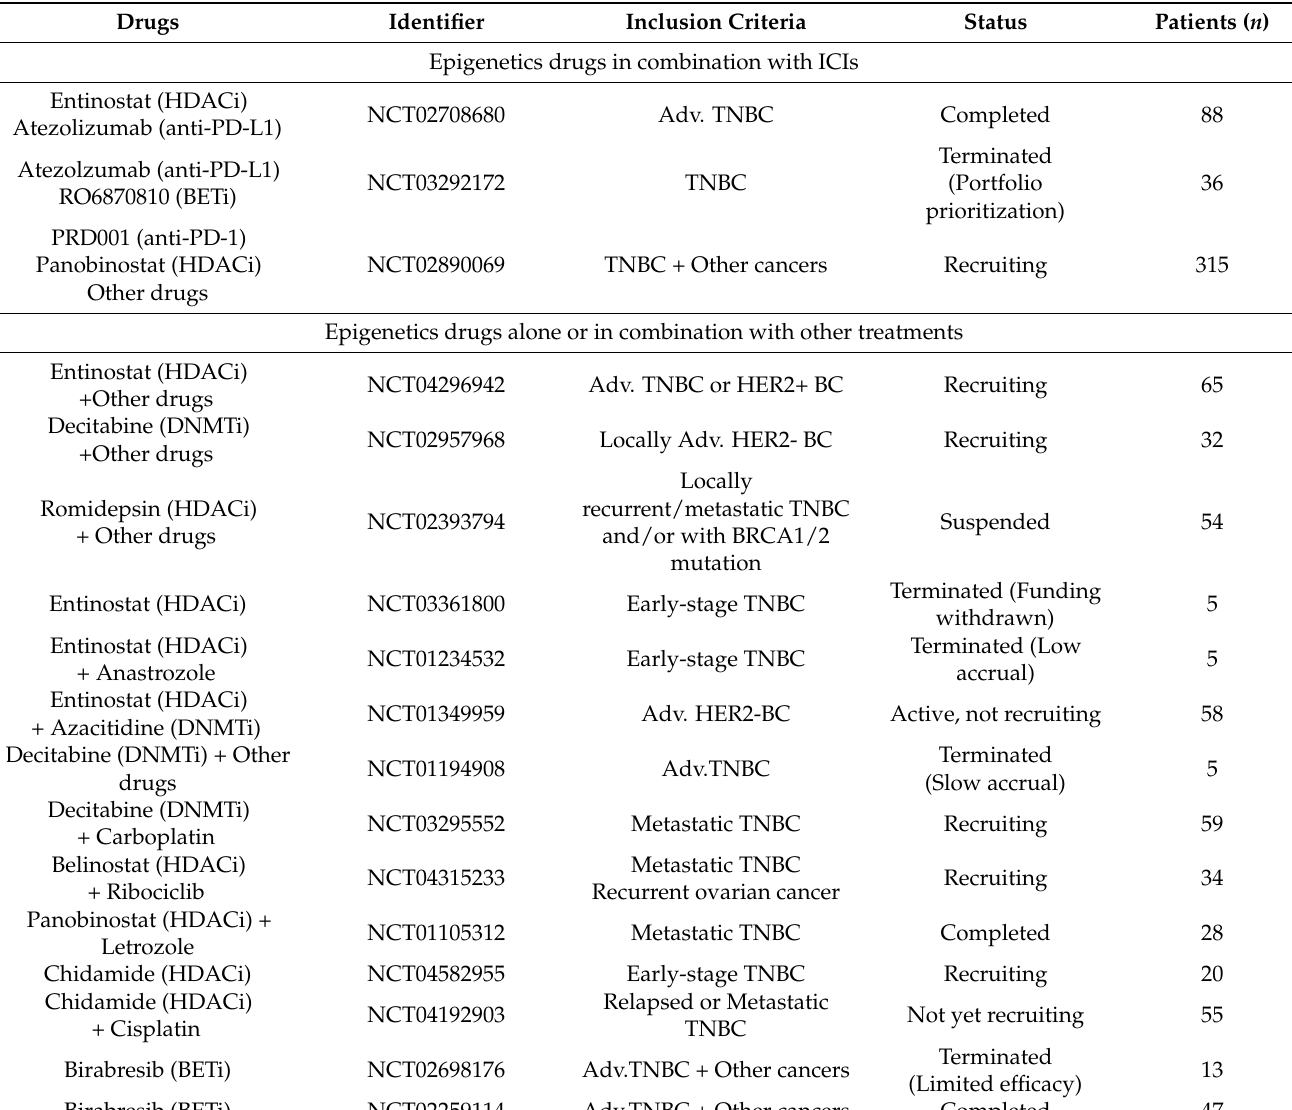
Table 1. Ongoing clinical trials of epigenetic drugs in